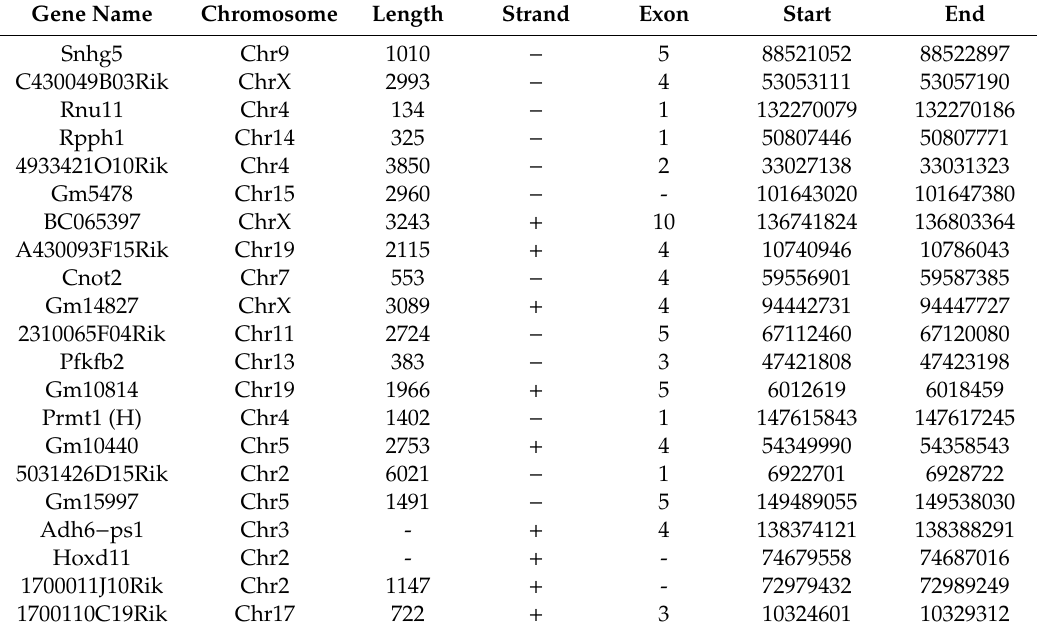
Table 1. Common di ff erentially expressed ncRNAs identified in EPC-, CPC-, and CBSC-derived EVs in